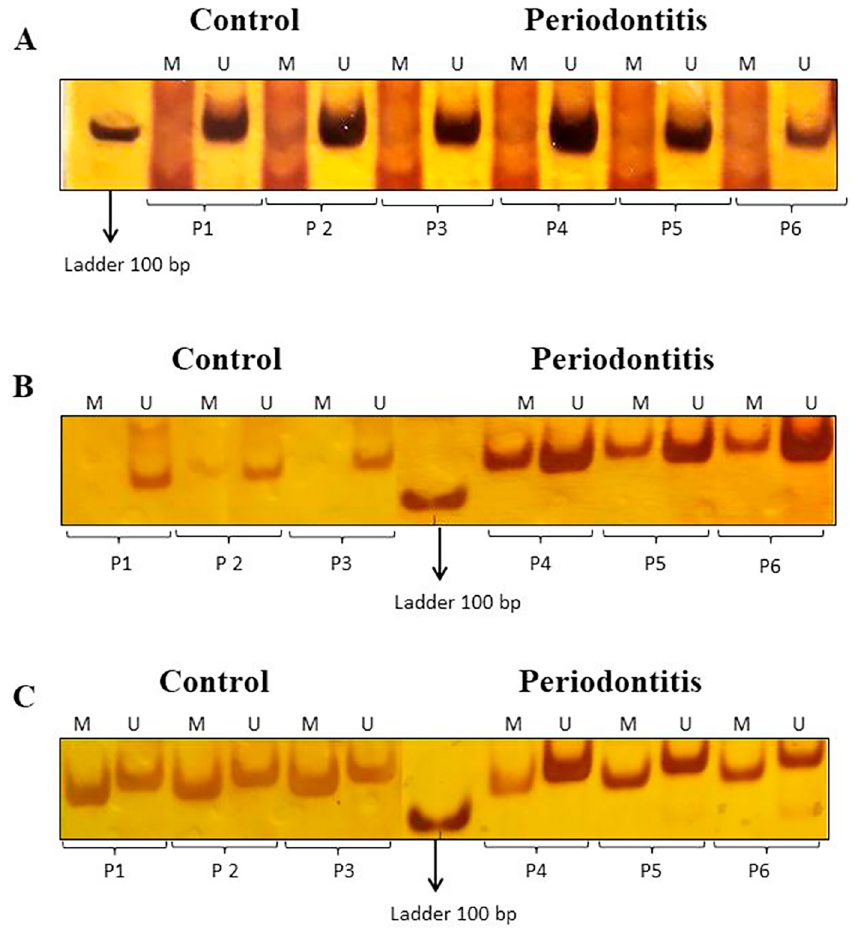
Figure 2- Representative bands of MTHFR and miR-9 stained with silver nitrate following amplification by MSP method for both control and periodontitis groups. (A) Amplicons for methylated and unmethylated (198 bp) status of the MTHFR gene promoter; (B) Amplicons for methylated and unmethylated (110 bp) status of the miR-9-1 gene promoter; (C) Amplicons for methylated and unmethylated (116 bp) status of the miR-9-3 gene promoter. M=methylated, U=unmethylated. P1-P6=patient 1–patient